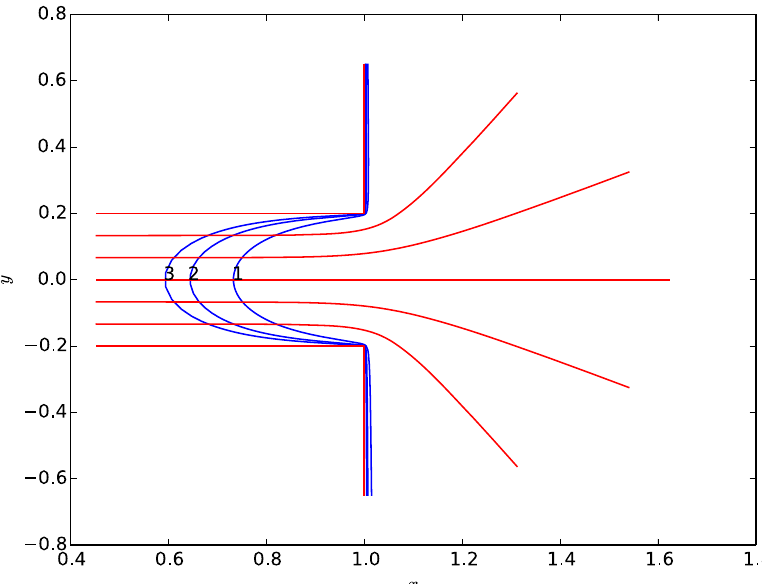
Figure C1. The blue curves are x + iy = z = f − 1 ( e z = ζ + (cid:15) n i) for ζ varying between − 5 and 5 and (cid:15) n = 0 . 06 /n . The three blue curves correspond to n = 1 , 2 , 3. The smaller the parameter (cid:15) n becomes, the further left these blue curves will reach (the left extremities of these curves are approximately 2 a ln ((cid:15) n ) where a is 0.2). The red curves are the π